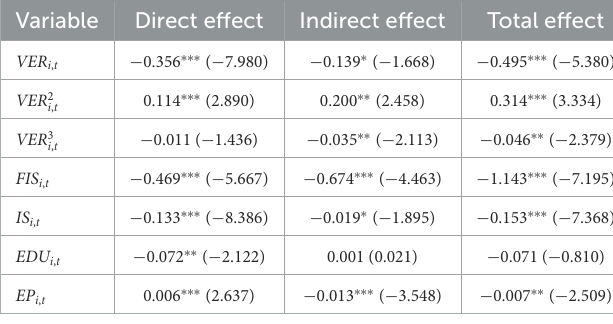
TABLE 6 Decomposition results of the effect of VER on